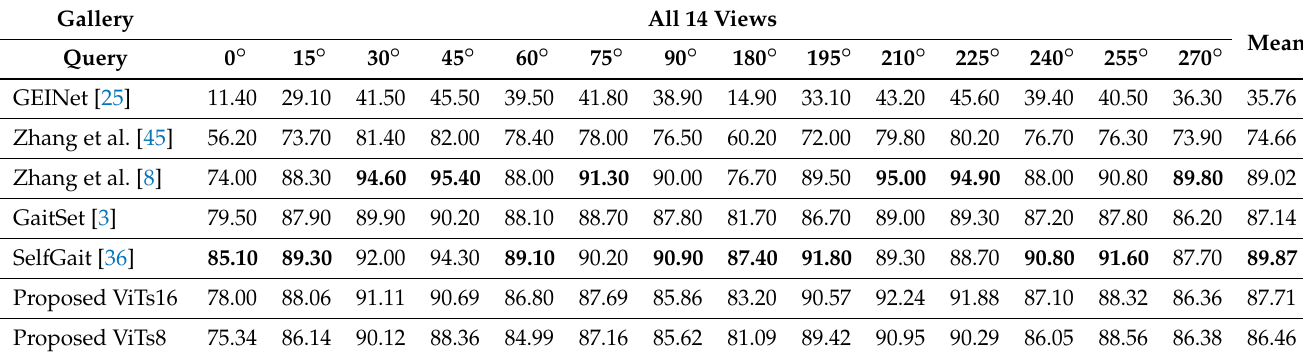
Table 4. Results for OU-MVLP dataset. The best results for each angle and overall are in